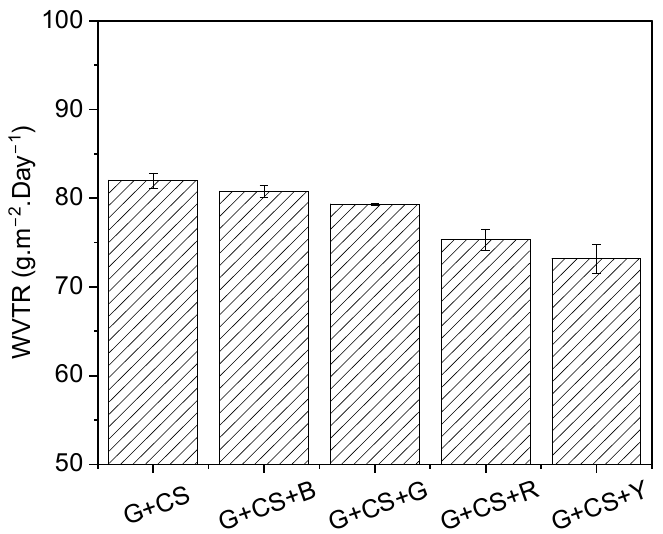
Figure 10. Effect of food color on the water vapor transmission rate (WVTR) of gelatin–cornstarch- based edible films.